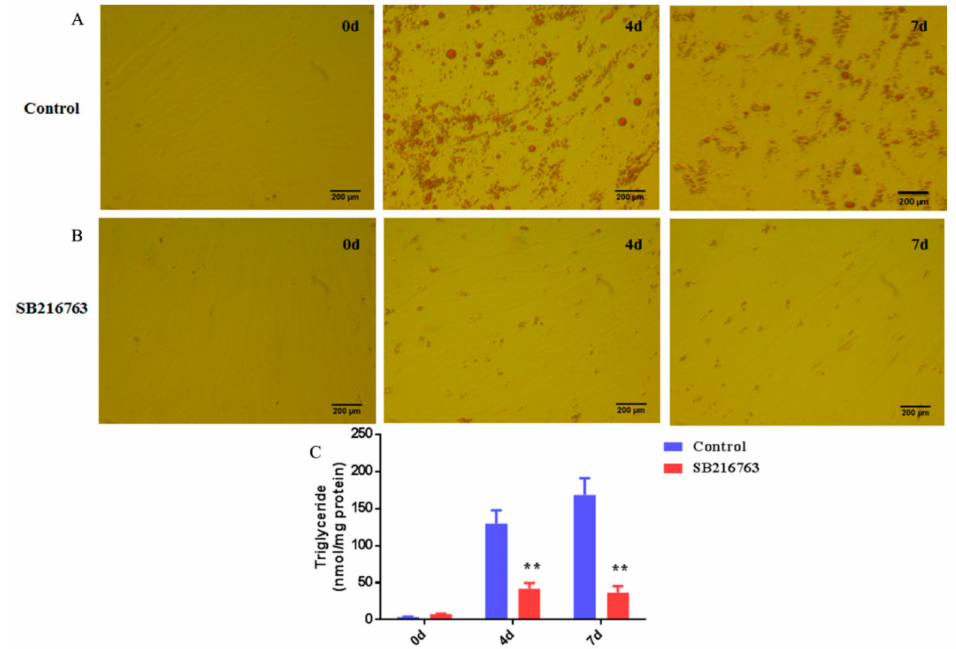
Figure 4. Inhibition of GSK3 β decreased lipid accumulation in muscle satellite cells. ( A , B ) Cells were fixed and stained with Oil Red O on day 0, day 4 and day 7 with or without SB216763 treatment for 4 and 7 days. ( C ) Quantitative analysis of triglyceride (TG) content after the SB216763 treatment during the adipogenic di ff erentiation. Error bars represent the SEMs of three separate experiments. ** p < 0.01 relative to TG content of without SB216763 treatment.